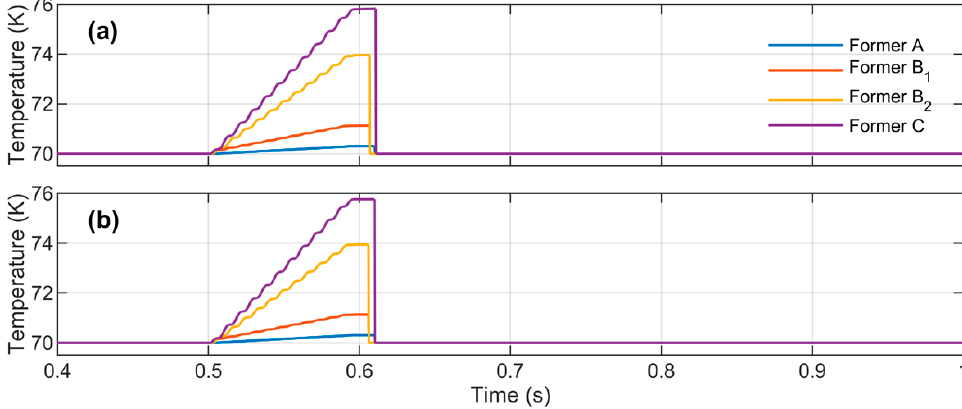
Figure 16. Tested system in case of DCR failure. Figure 17. Relay trip signals in case DCR fails: ( a ) relays in HTS 1 ; ( b ) relays in HTS 2 .